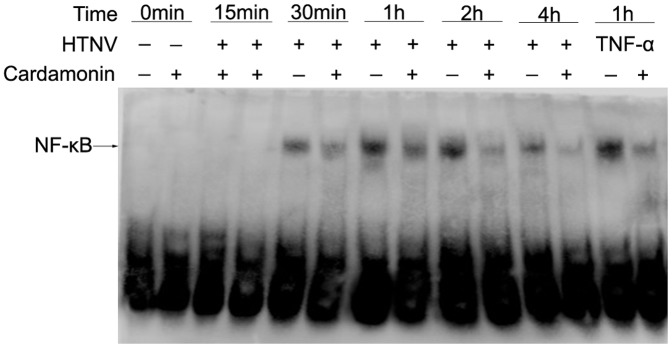
Effect of cardamonin on the HTNV-induced nuclear translocation of NF-κB.HUVECs were preincubated for 30-κB using EMSA as described before. A representative autoradiographic exposure is shown, and the arrow indicates the location of the DNA-NF-κB complexes. TNF-α-stimulated cells were used as positive control groups.